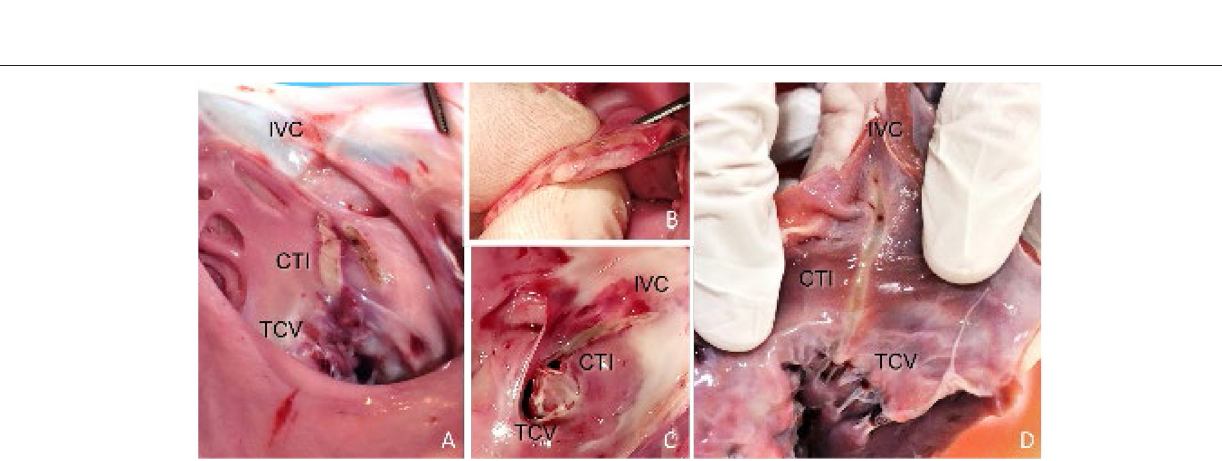
Frontiers in Medical Technology |